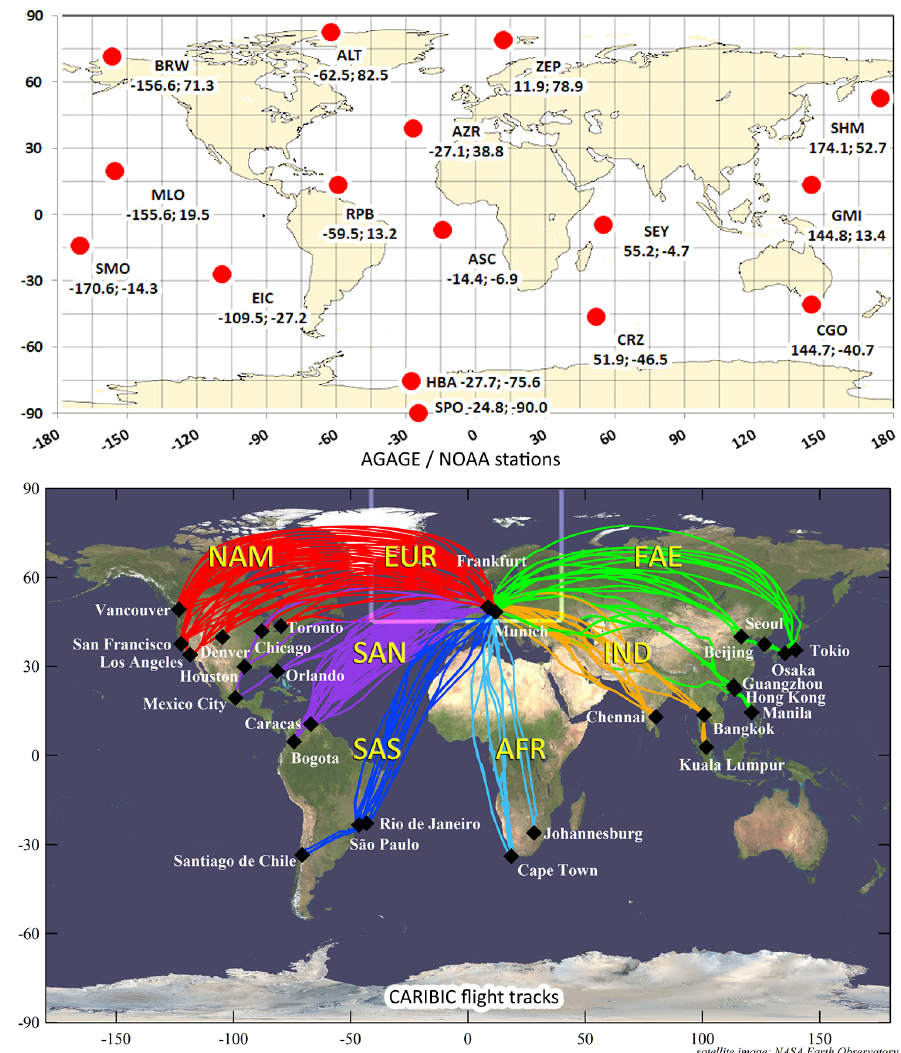
Figure 2. (a) Map of NOAA sampling locations for greenhouse gases used for reference in this study (see Table 1 for names and coordinates). (b) CARIBIC flights and destinations